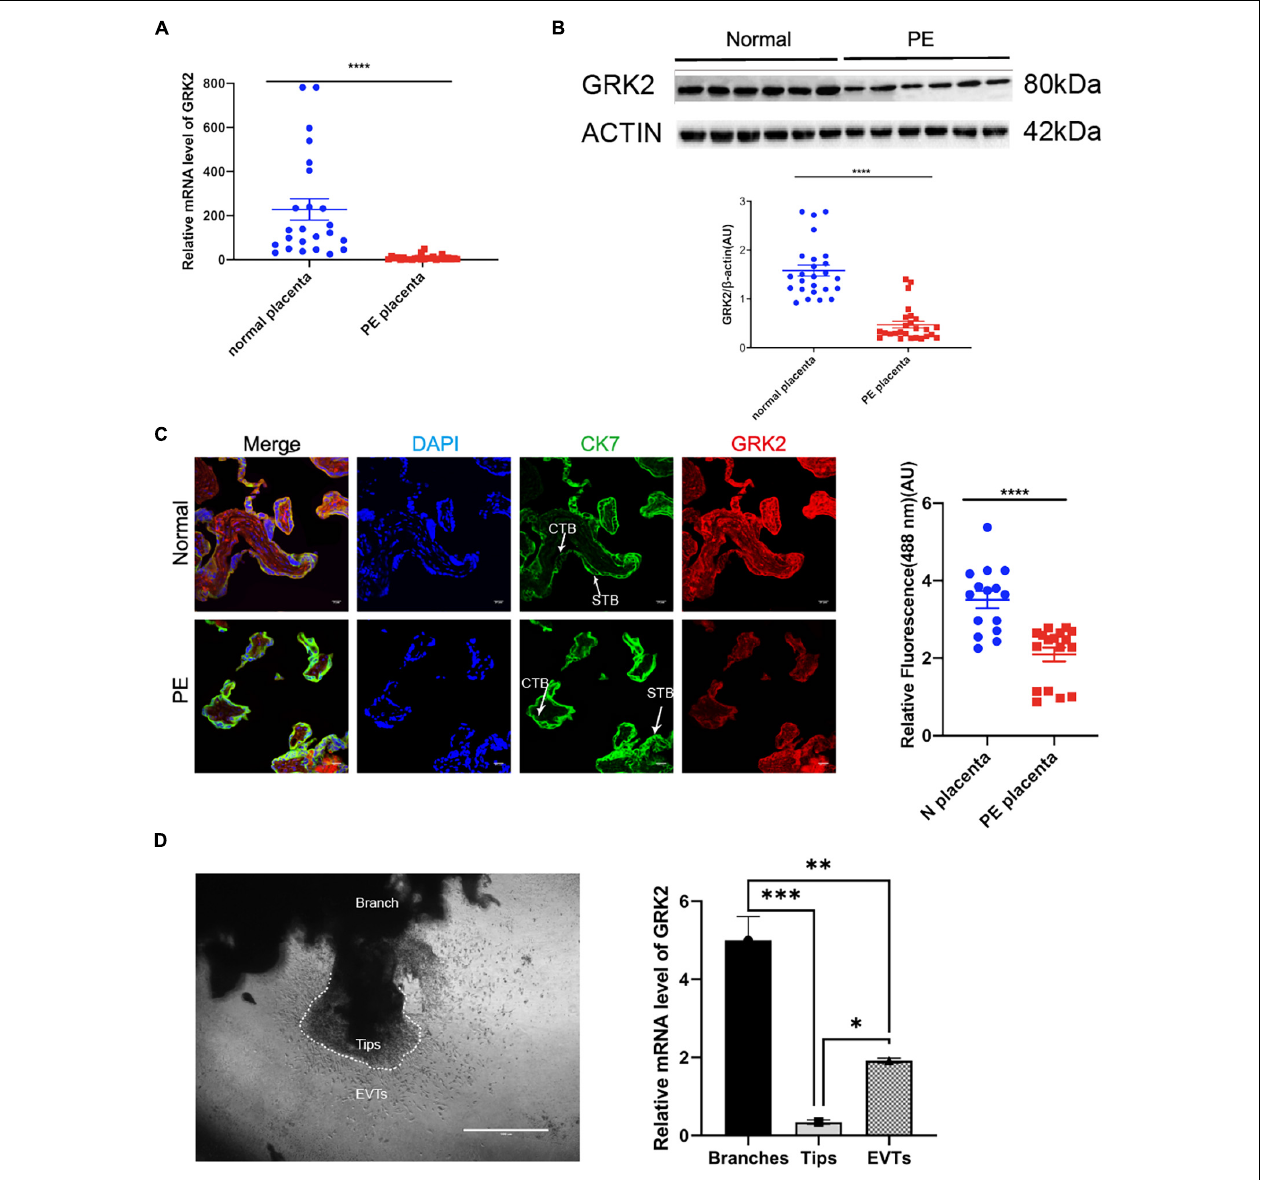
FIGURE 1 | Reduced expression of GRK2 characterizes the preeclamptic placenta. (A) GRK2 mRNA levels were determined in the term placenta samples by qRT-PCR. Each dot is representative of a patient sample. (B) Western blotting revealed the protein levels of placental GRK2. Each dot is representative of a patient sample. (C) Immunofluorescence co-staining and quantification of GRK2 (red), CK7 (green; trophoblasts), and DAPI (blue; nuclei) in term placentae. Scale bar, 100 µ m. (D) qRT-PCR analysis of GRK2 mRNA abundance in the first-trimester villous explants ( n = 8). The tips, branches, and EVT outgrowth cells were isolated along the villus explants on Matrigel-coated wells at 48 h post-explant. Data are shown as the mean ± SEM. PE, preeclampsia; GRK, G Protein-Coupled Receptor Kinase; CTB, cytotrophoblast; STB, syncytiotrophoblast; EVT, extravillous cytotrophoblasts. ∗ P < 0.05, ∗∗ P < 0.01, ∗∗∗ P < 0.001; **** P <